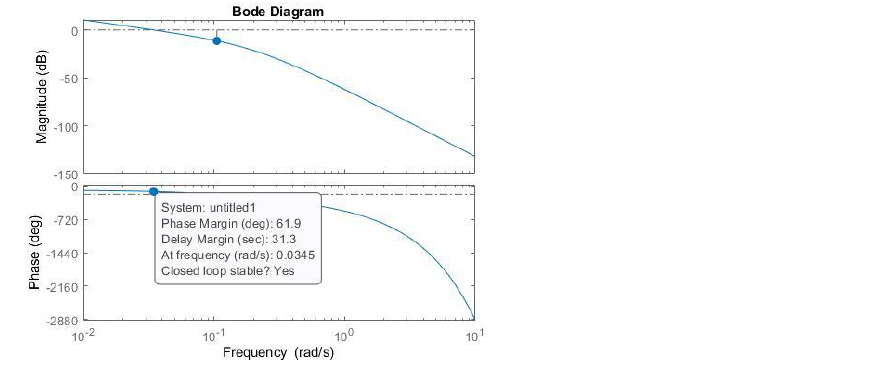
Figure 11. Bode diagram of the open-loop system for the second designed FO-PID controller.